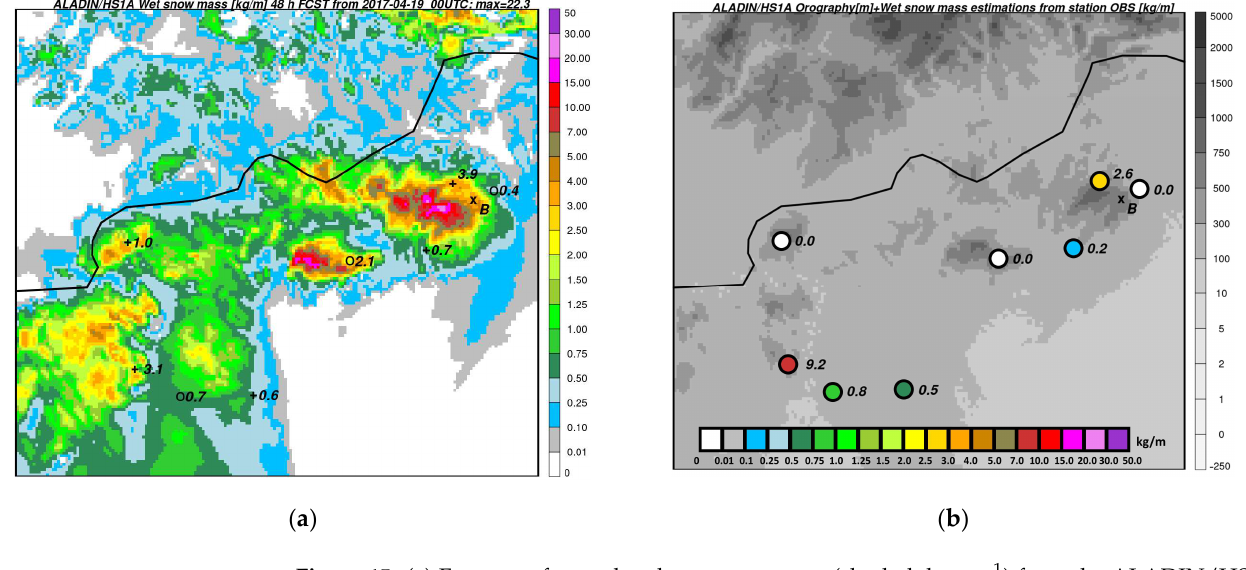
Figure 15. ( a ) Forecast of cumulated wet snow mass (shaded, kg·m −1 ) from the ALADIN/HS1A run based on 19 April 2017 00 UTC and valid for 21 April 2017 00 UTC in the region of northern Hungary from an experiment defining density of wet snow as 500 kg·m −3 . Meaning of numbers and characters as in Figures 12 and 13; ( b ) ALADIN/HS1A model orography (m). Numbers and colored circles show the mass (kg·m −1 ) estimated from both station observations and NWP data and cumulated for the same period and with the same setup of wet snow density as in ( a ). Compare with Figure 12c,d for the wet snow density of 300 kg·m −3 .